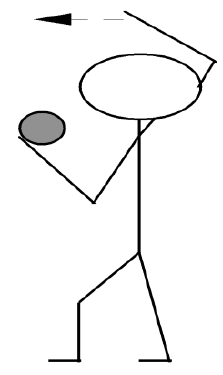
Figura 1. Saque tipo tênis do